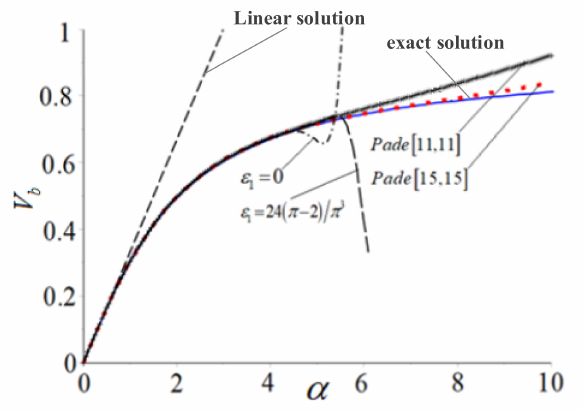
Figure 2. Comparison of vertical displacement at the free end V b with n =